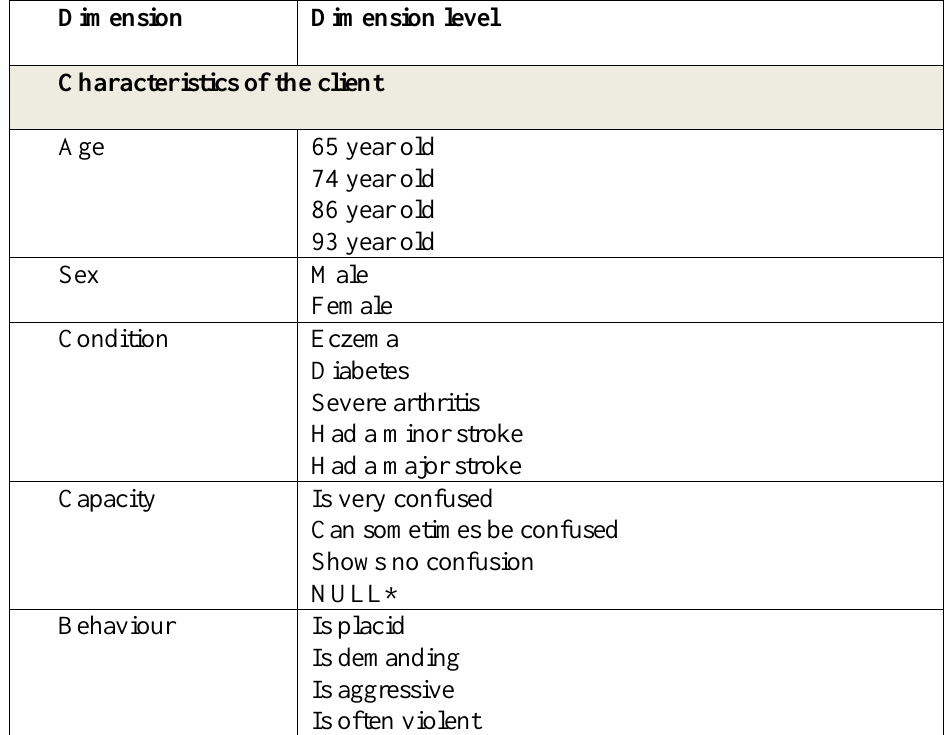
Factorial survey design in Killick & Taylor (2012) Dimension Dimension level Characteristics of the